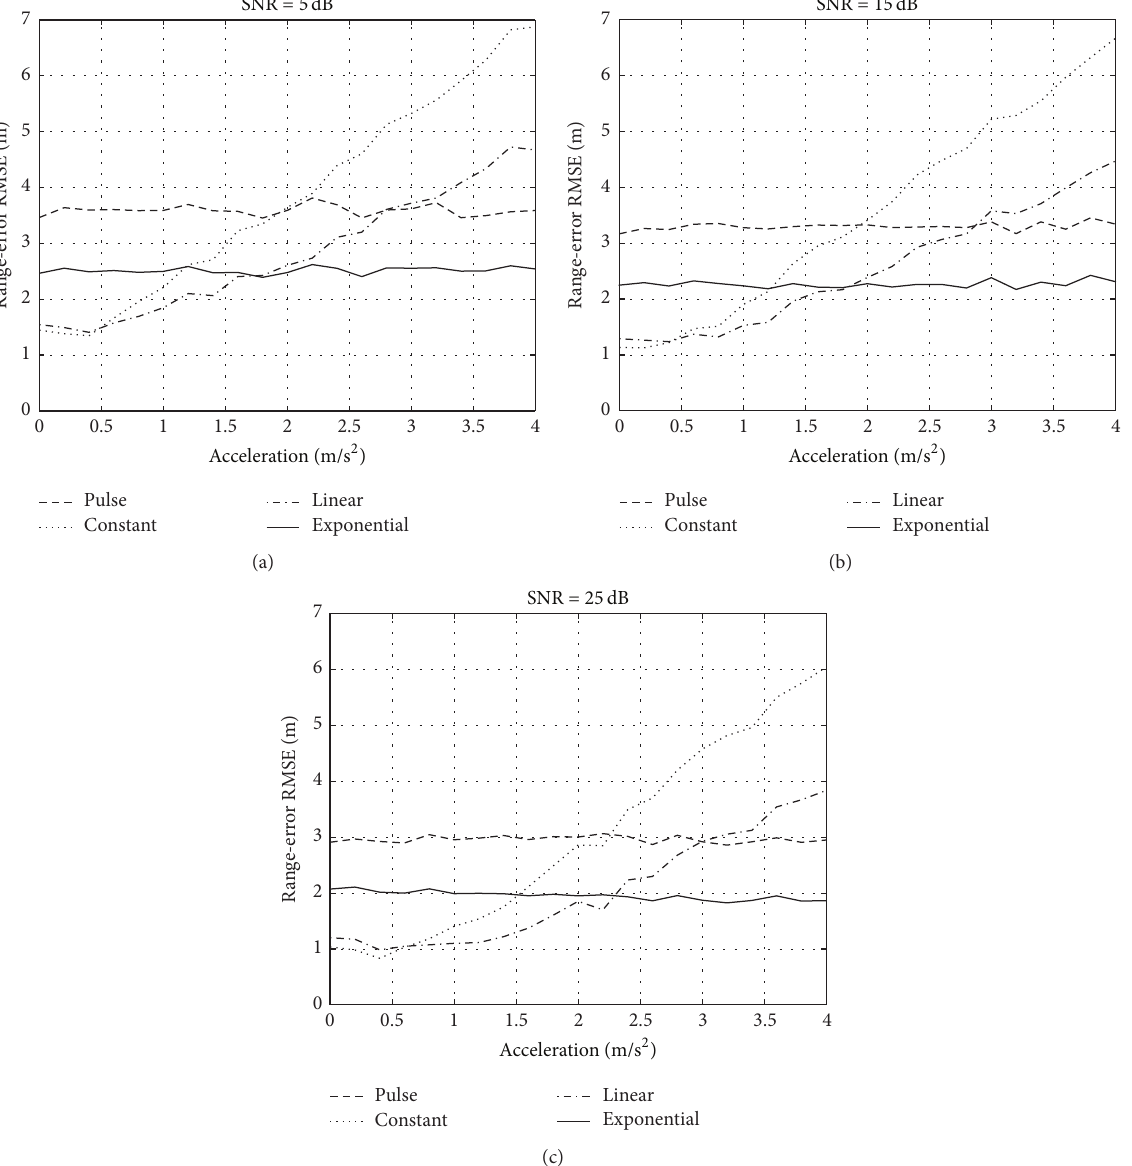
Figure 10: Range-error RMSEs of different forgotten factors versus acceleration with V = 1 m/s. (a) SNR = 5 dB, (b) SNR = 15 dB, and (c) SNR = 25